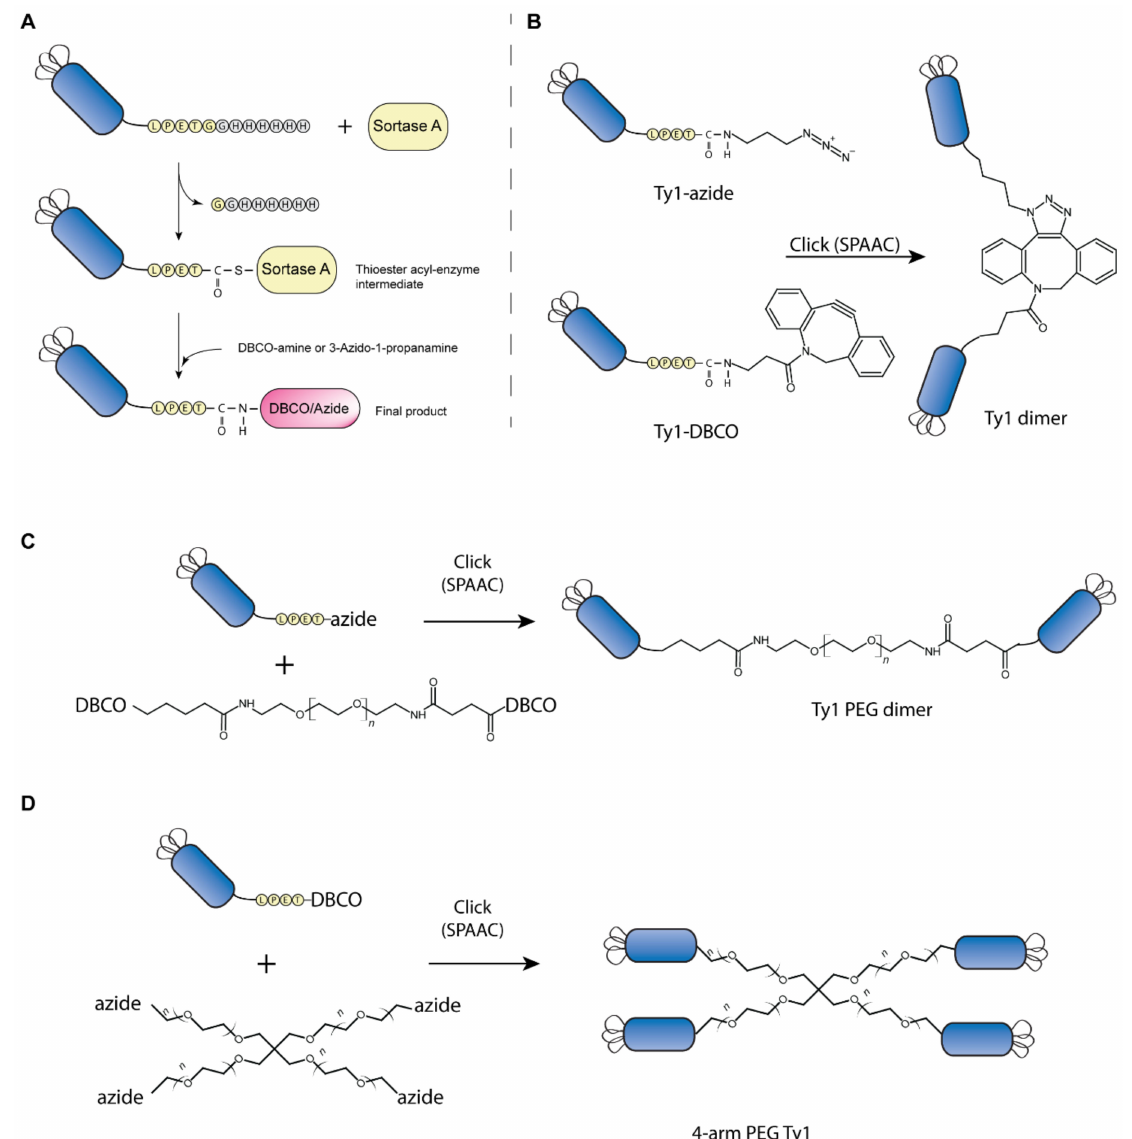
Figure 1. Sortase A mediated functionalization of nanobodies and assembly of multimeric nanobody constructs. ( A ) Sortase A recognizes LPXTG motifs near the C-terminus, cleaves the motif after the threonine and forms a thioester acyl-enzyme intermediate. The C-terminal HIS-tag is cleaved o ff in the process. The acyl-enzyme intermediate is resolved by the addition of the amine nucleophile DBCO-amine or 3-Azido-1-propanamine, which leads to release of sortase and results in ligation of the molecules to the C-terminus of the nanobody. ( B ) Purified DBCO and azide functionalized nanobodies are incubated for strain-promoted azide-alkyne click chemistry (SPAAC) that results in C-to-C-terminal nanobody fusion and dimer formation. ( C ) Nanobody dimers connected via polyethylene glycol (PEG)-linker molecules are generated by click reactions of azide-labeled nanobodies on bis-PEG-DBCO. ( D ) To expand valency, DBCO-labeled nanobodies are attached to multi-arm PEG-azide molecules. Note that illustrations of constructs and PEG-linkers are not to